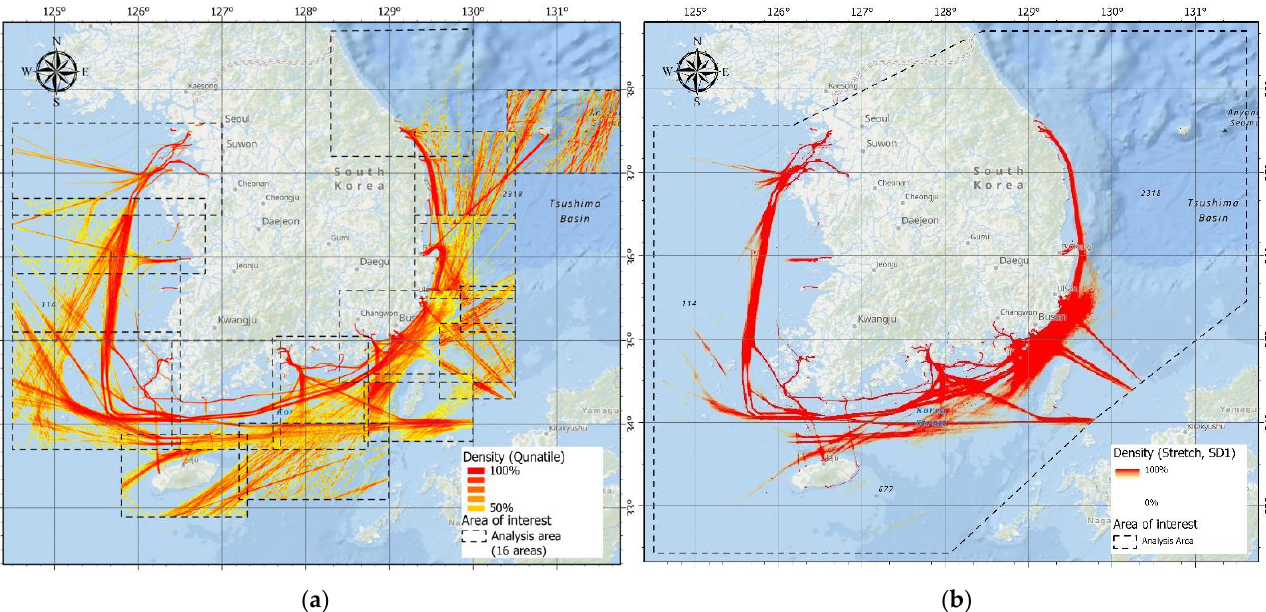
Figure 8. Comparison of ship traffic densities in the coastal area of Korea analyzed and visualized using two sets of methods: ( a ) Lee et al. [31] used the top 50% of total traffic volume for route extraction via the line density analysis and quantile methods; ( b ) the present study uses the top 25% of the total traffic volume for main route extraction using spatial-temporal density analysis and standard-deviation-based stretch symbolization.